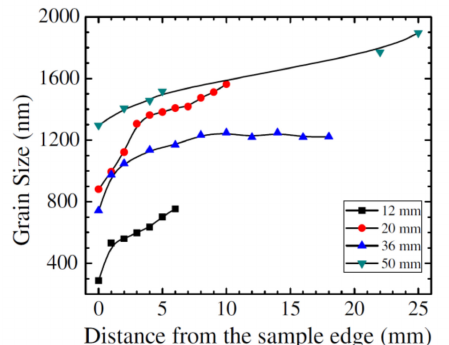
Figure 3. Grain size evolution for pure alumina samples as a function of the distance from the sample edge and the die / sample diameter. For all samples sintered in SPS, a constant 100 K / min heating rate was used up to a peak temperature if 1300 ◦ C with no dwell time. For the 20 mm diameter sample, an abnormally large grain size di ff erence can be observed in accordance with the predictions from the modeling work [48]. (reprinted with permission from Elsevier).